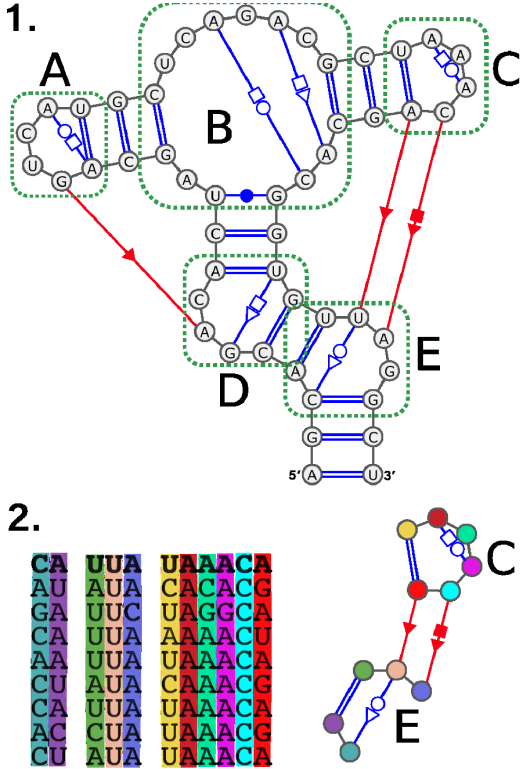
Fig 1. Secondary structure and module. In (1) we show an RNA and its secondary structure with non-canonical interactions. Base pair interactions in blue are local (both nucleotides involved are in the same or in adjacent SSEs) while the ones in red are long range interactions (between two distant SSEs). The canonical base pair interactions are represented with double lines. We highlighted the loops in the structure with green dotted lines. Loops A and C are hairpins, loops D and E are interior loops, and loop B is a multi-loop. In (2) we show an instance of a module found in the RNA secondary structure in (1). On the right is the base pair pattern that characterizes this module and on the